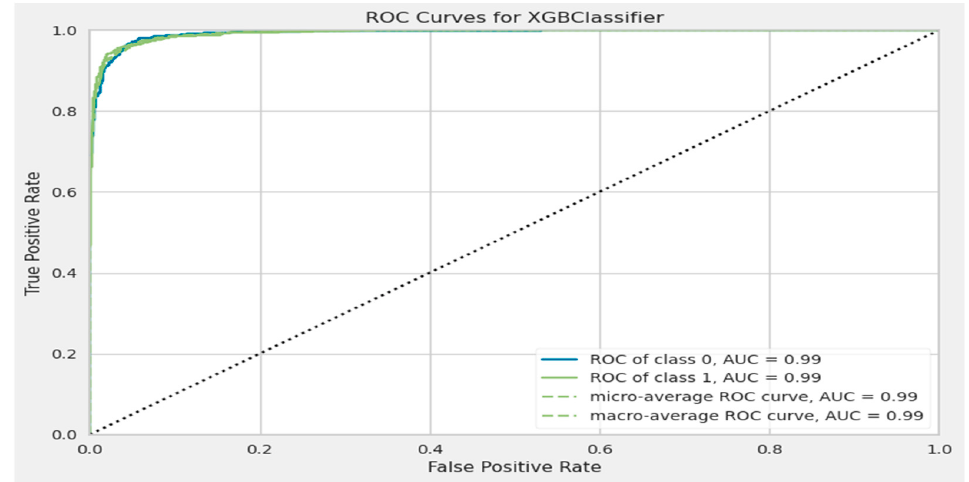
Figure 11. The XGBoost model’s ROC curve after the hyper-parameter tuning.